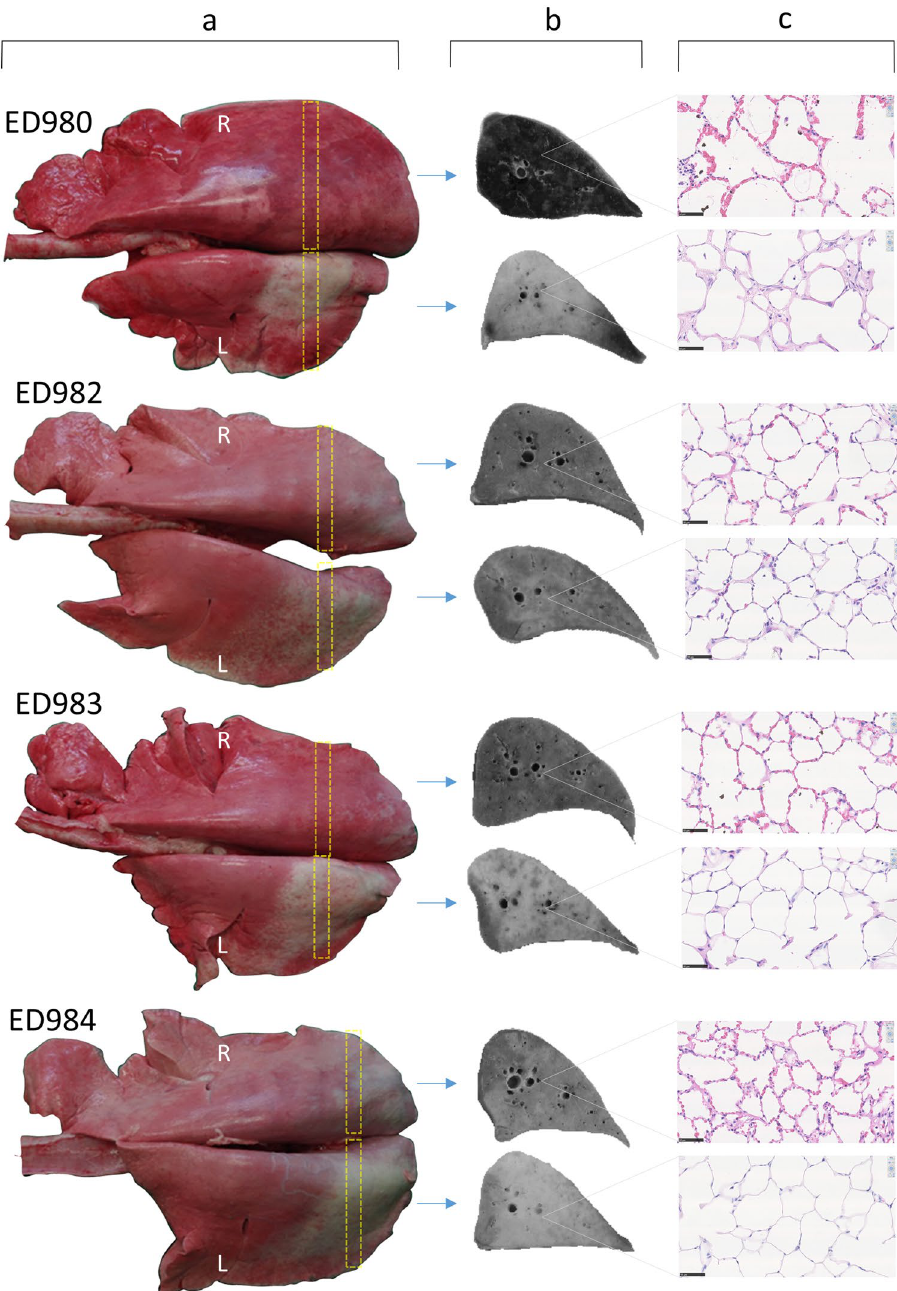
Figure 1. Gross and histological features associated with chronic RILI. Column ( a ): Gross features evident at post mortem examination demonstrated pallor on the pleural surface overlying the radio-exposed volume of the left (L) lung which was variable in extent, ranging from sparse mottling (ED982) through to a more uniform distribution (ED980, ED983 & ED984), with discernible thickening and evident contraction in one case (ED980). Column ( b ): Following inflation fixation each lung was sectioned into 1 cm thick transverse slices. A representative greyscale image of a slice (yellow boxes with dashed borders) derived from the centre of the radiation field, and the contralateral control lung (R) is depicted. The images demonstrate that the variable pallor evident on the pleural surface extends through the lung substance, being most noticeable and uniform in the lungs of ED980 and ED984, more mottled in ED983, and less evident in ED982. Column (c): Representative histological images captured from haematoxylin and eosin-stained sections demonstrate the association between pallor and the absence of erythrocytes in the peripheral microvasculature (scale bars = 50